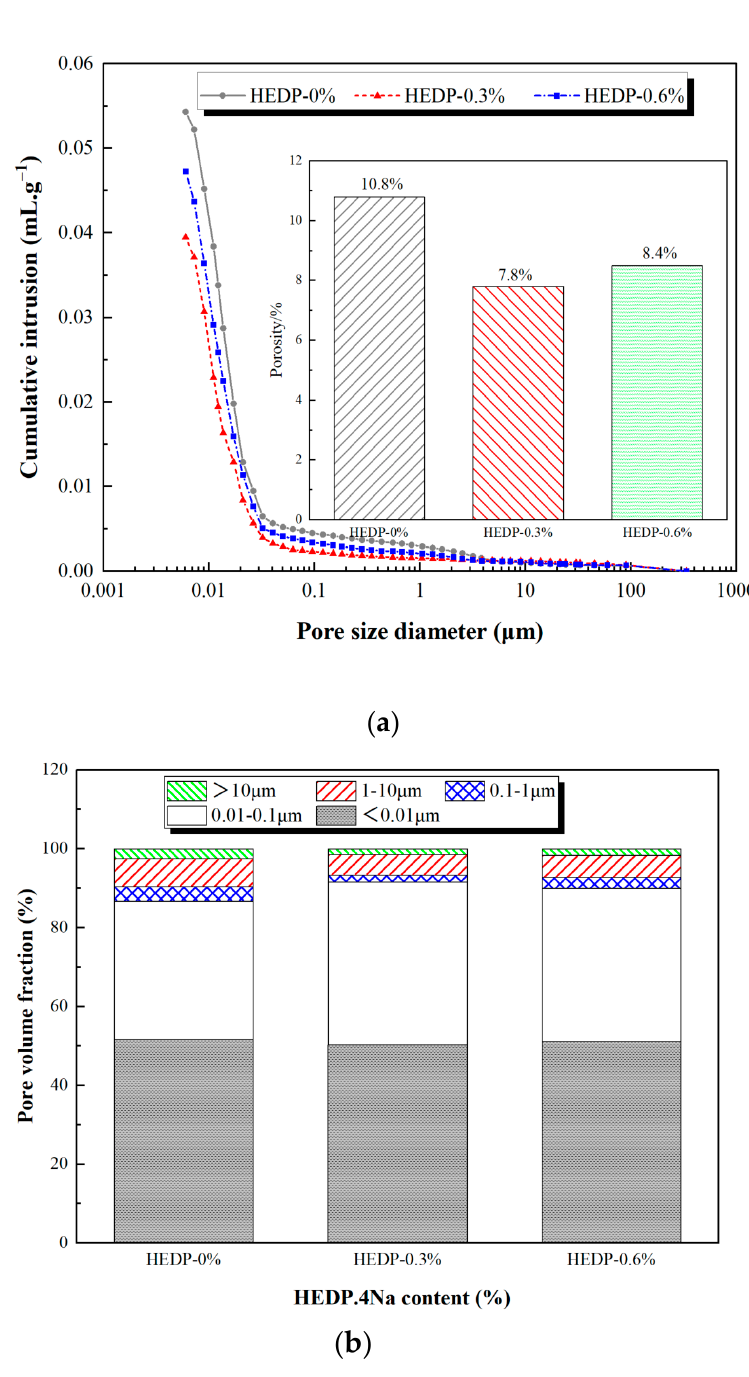
Figure 9. Pore structure of 28d FR-AASC. ( a ) Pore porosity, ( b ) Pore volume fraction.